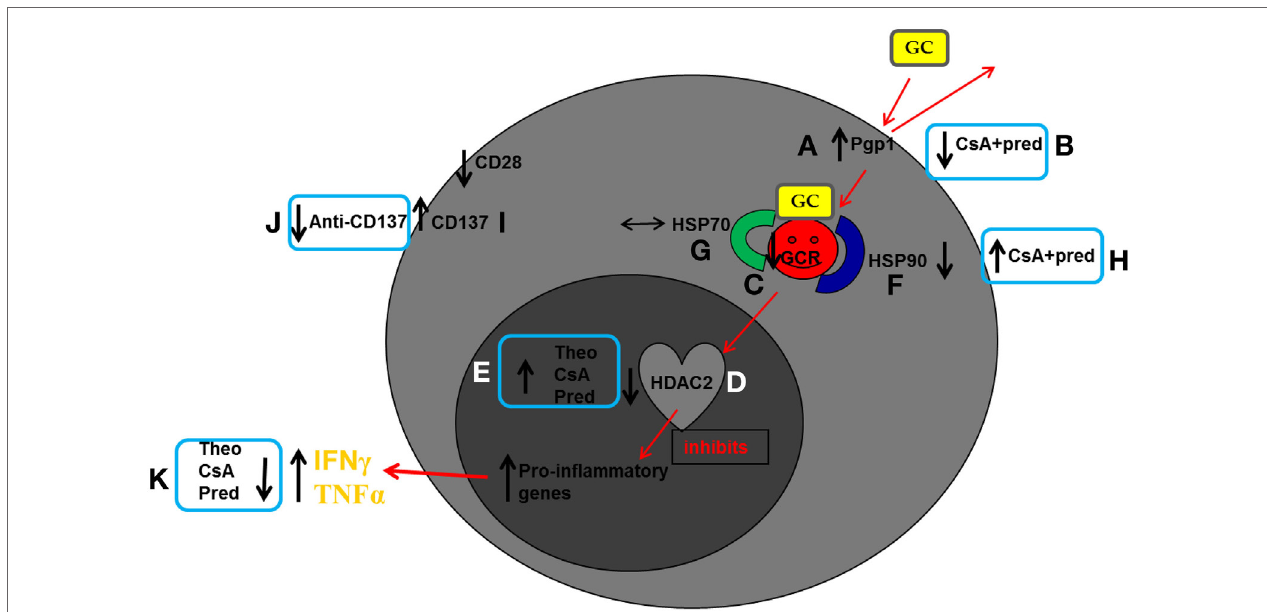
FigURe 2 | Schematic diagram summarizing reported findings in peripheral blood CD8 + CD28 null natural killer T-like (nKT-like) cells in chronic obstructive pulmonary disease (COPD) . Glucocorticoids enter cells by overcoming membrane drug efflux pump P-glycoprotein-1 (Pgp1) and binding to the glucocorticoid receptor (GCR) in the cytoplasm. GCR must be bound to the molecular chaperones heat shock protein (Hsp)70 and Hsp90 to acquire a high-affinity steroid binding conformation, and traffic to the nucleus where engagement of histone deacetylases (HDACs), particularly HDAC2, results in reduction of pro-inflammatory gene activation. In COPD compared with age-matched healthy control subjects: (A) Pgp1 + NKT-like cells are increased in COPD, reducing intracellular levels of GC. Expression of GCR (C) , Hsp90 (F) , and HDAC2 (D) are decreased in CD8 + CD28 null NKT-like cells (no change in Hsp70) (g) reducing steroid effectiveness. (i) The percentage of steroid resistant CD8 + CD28 null CD137 + NKT-like cells is increased. Possible therapeutic targeting to overcome steroid resistance CD8 + CD28 null NKT-like cells in COPD: (B) Pgp1 is synergistically decreased in the presence of 2.5 ng/ml cyclosporine A (CsA) and 1µM prednisolone (pred). (H) Hsp90 expression is increased in the presence of 2.5 ng/ml CsA and 1µM pred. (e) HDAC2 expression is increased in the presence of 5 mg/ml theophylline, 2.5 ng/ml CsA, and 1µM pred. (J) Blocking CD137 expression with anti-CD137 antibody. (K) This targeting results in decreased IFN γ and TNF α pro-inflammatory cytokine